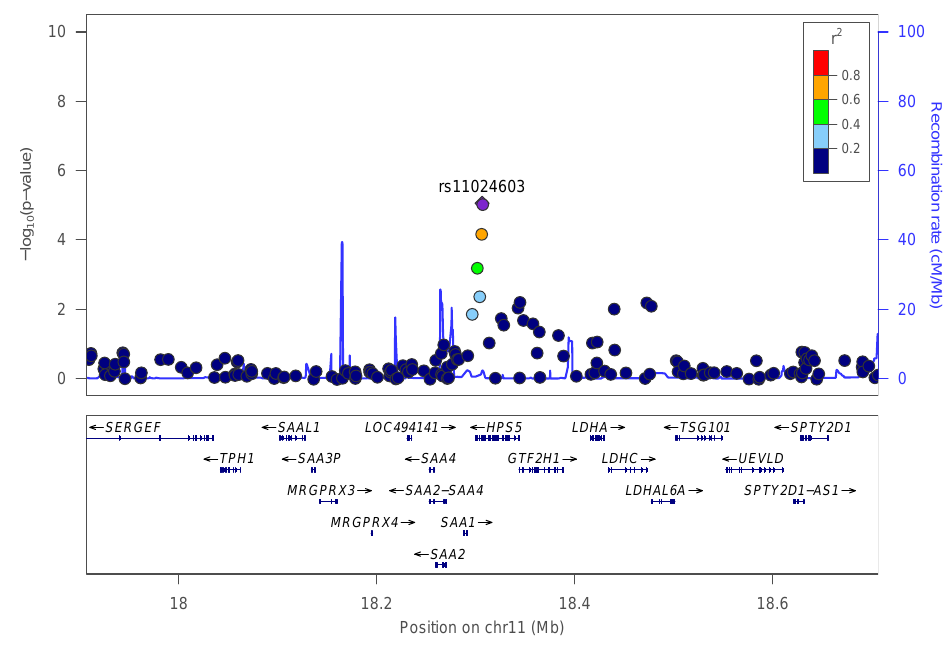
Figure 2. Regional plot for the SNP rs11024603, located in the Hermansky–Pudlak syndrome (HPS5) gene, on chromosome 11 in the GWAS, for adiponectin concentrations in the whole population. p -values obtained in the general linear regression model adjusted for sex, age, diabetes and